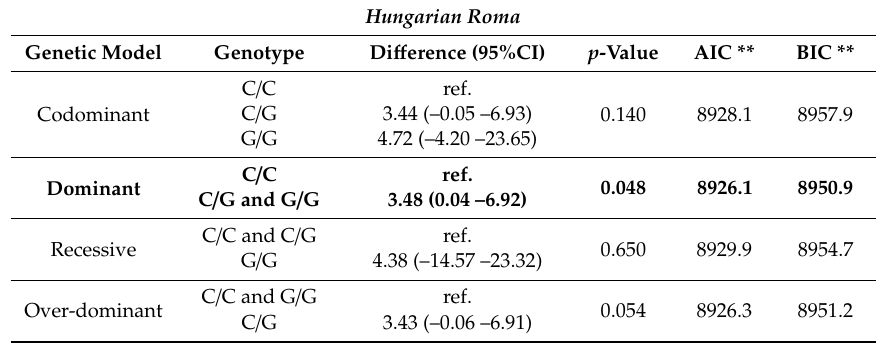
Table 3. Result of adjusted β value * in genetic models for candidate gene polymorphism PPAR γ (rs1801282) on the waist circumference as continuous outcome. The most frequent homozygote genotype was considered as the reference (ref.)